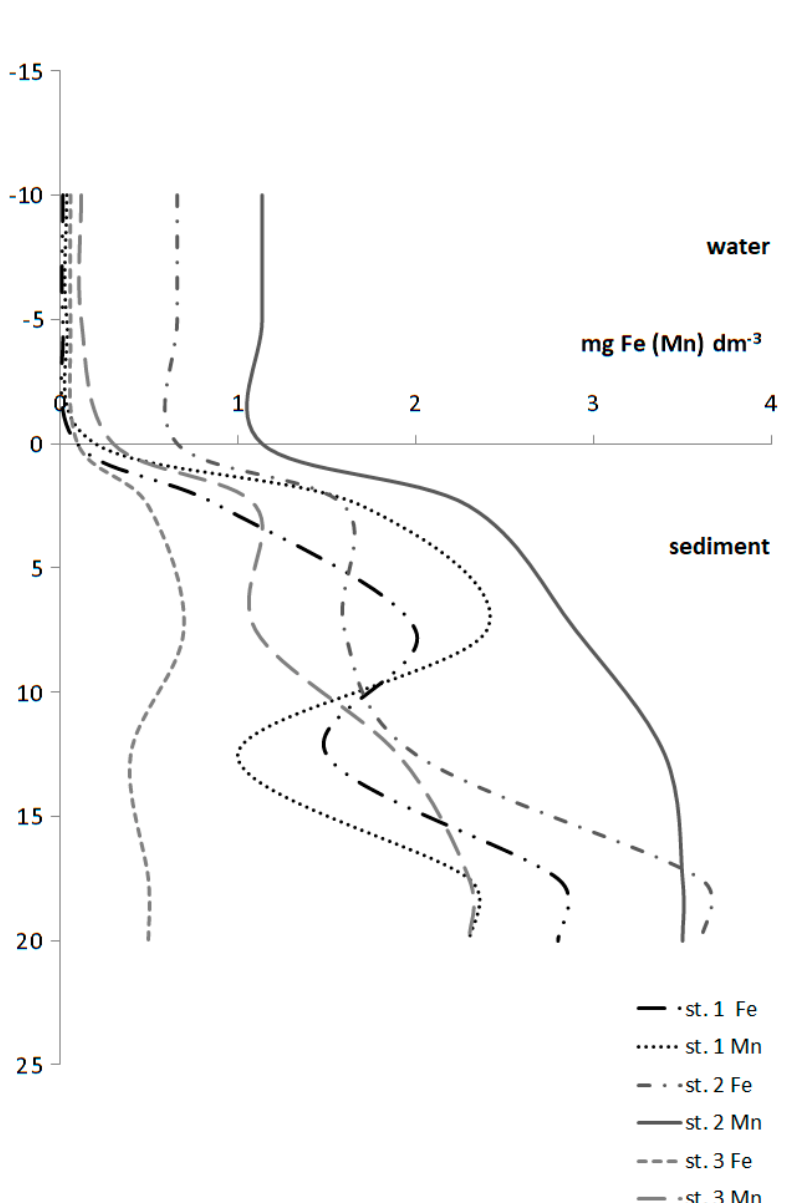
Figure 7. The Fe and Mn profiles in the water-sediment interface of Długie Lake.